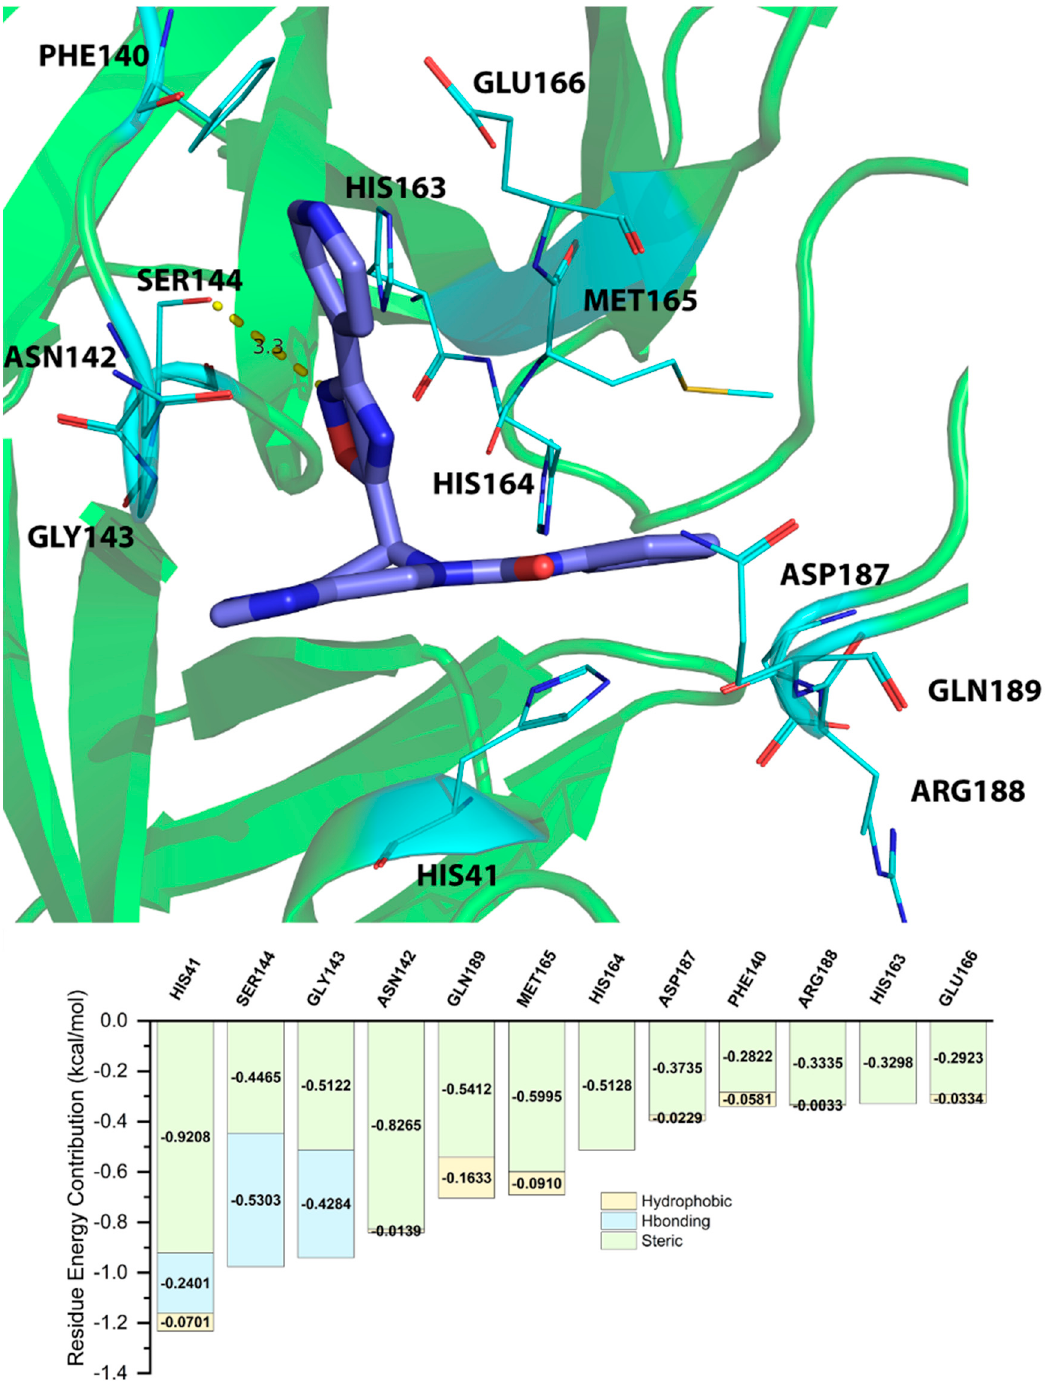
Figure 4. Binding poses between ZINC12530139 and the 3CL pro of SARS-CoV-2 predicted by MD simulation and residue energy contribution between ZINC12530139 and 3CL pro of SARS-CoV-2 predicted by MCCS.